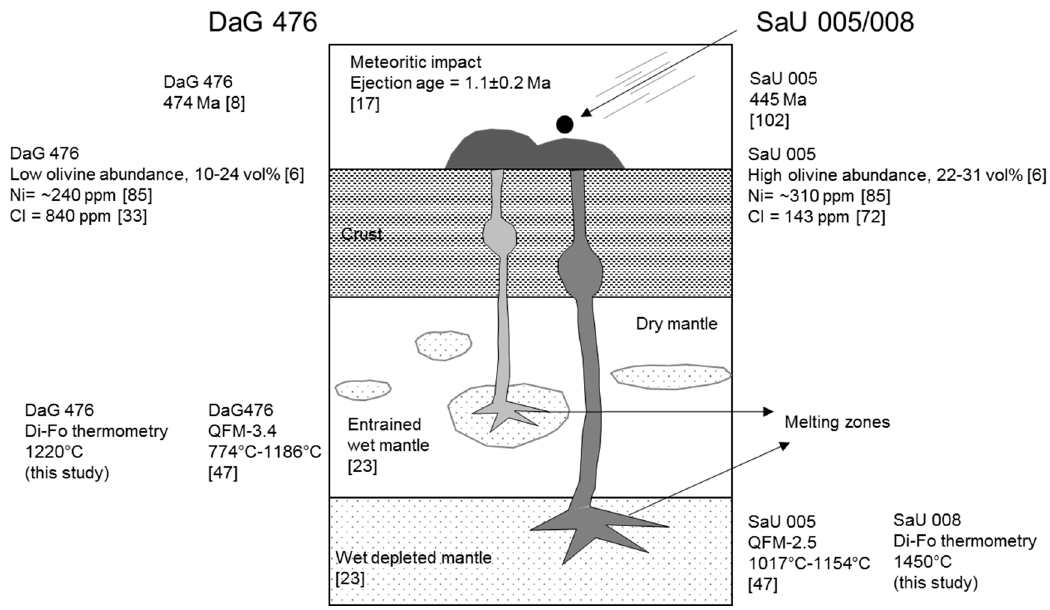
Figure 4. A simplified schematic diagram showing petrogenetic relationship between DaG 476 and SaU 005/008, modified after [15,23]. The data of SaU 005 is used here for SaU 008, assuming that these meteorites are paired. Both DaG 476 (474 ± 11 Ma; [8]) and SaU 005 (445 ± 18 Ma; [102]) belong to Amazonian era when lower wet (depleted) and upper (degassed) dry (intermediate/enriched) mantle existed along with scattered pockets of hydrous materials in the upper dry mantle. Depth is not to scale.